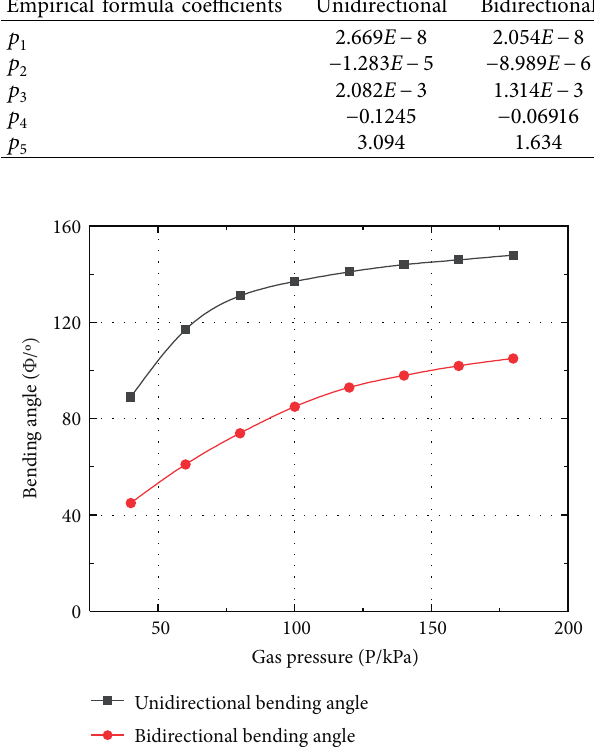
Figure 9: P − Φ characteristic curves of pneumatic soft-bodied bionic basic execution units.